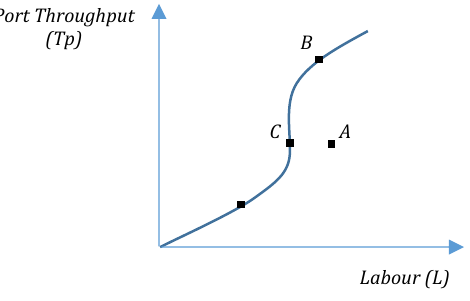
Figure 2: Port Cost Minimization for a Single Port